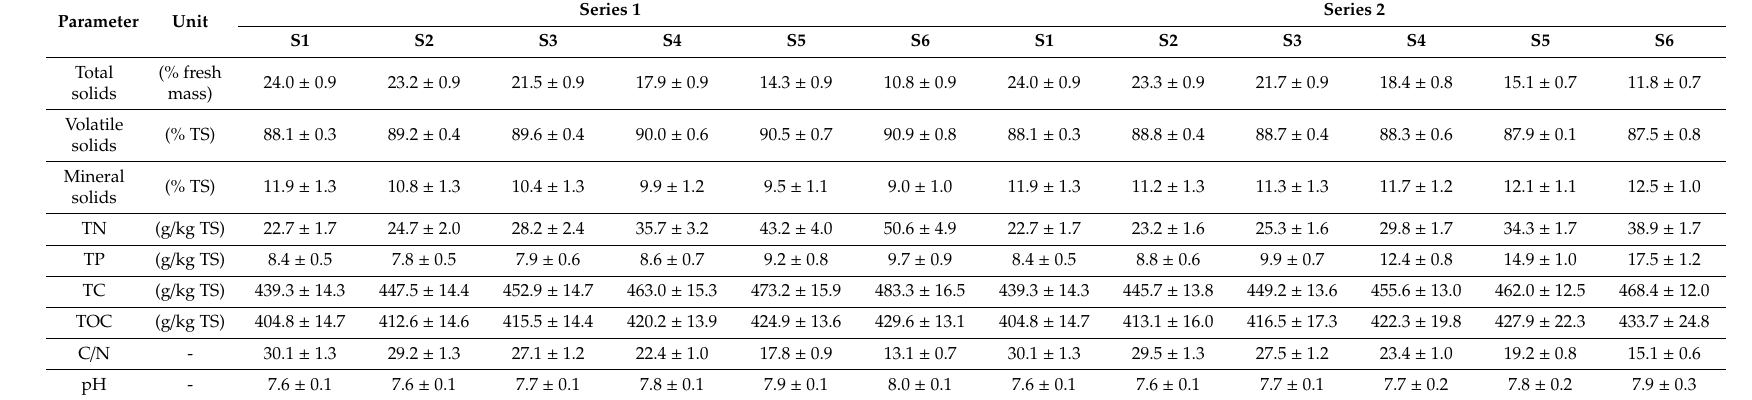
Table 3. Characteristics of substrates mixtures used as the feedstocks for anaerobic digestion in experimental setups (S)